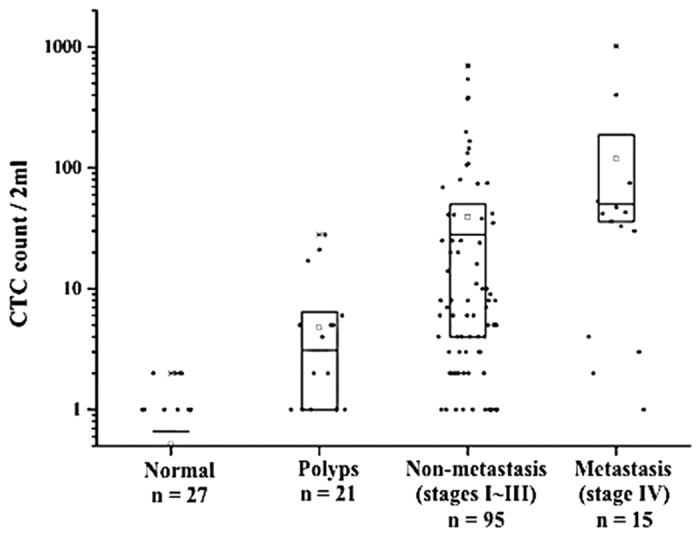
CTC count in different patient groups.The square in the box represents the mean. The upper and middle line of the box represent the mean ± 1 σ. The bottom line of the box represents the median.